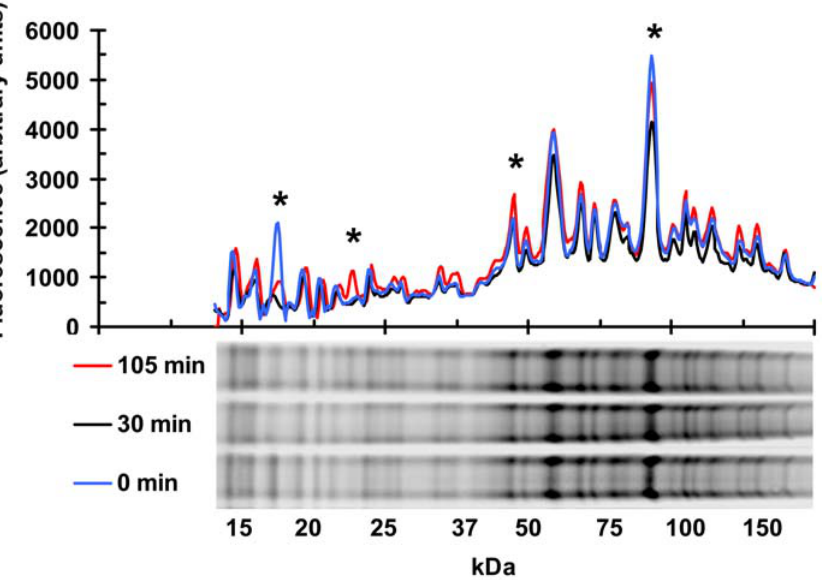
Figure 5. Protein thiol reactivity changes in H 2 O 2 stressed S.solfataricus . Proteome-wide labeling of free cysteine thiols, with BODIPY maleimide, shows that there is a population of redox sensitive proteins. Plot on the top shows the average fluorescent signal with respect to molecular weight. The fluorescent signal from three experiments was combined and normalized for total protein. The gel lanes at the bottom show the actual data form one experiment; with 0 ( blue line ), 30 ( black line ) and 105 minute ( red line ) samples. * indicates protein bands that were highly sensitive to changes in redox potential.